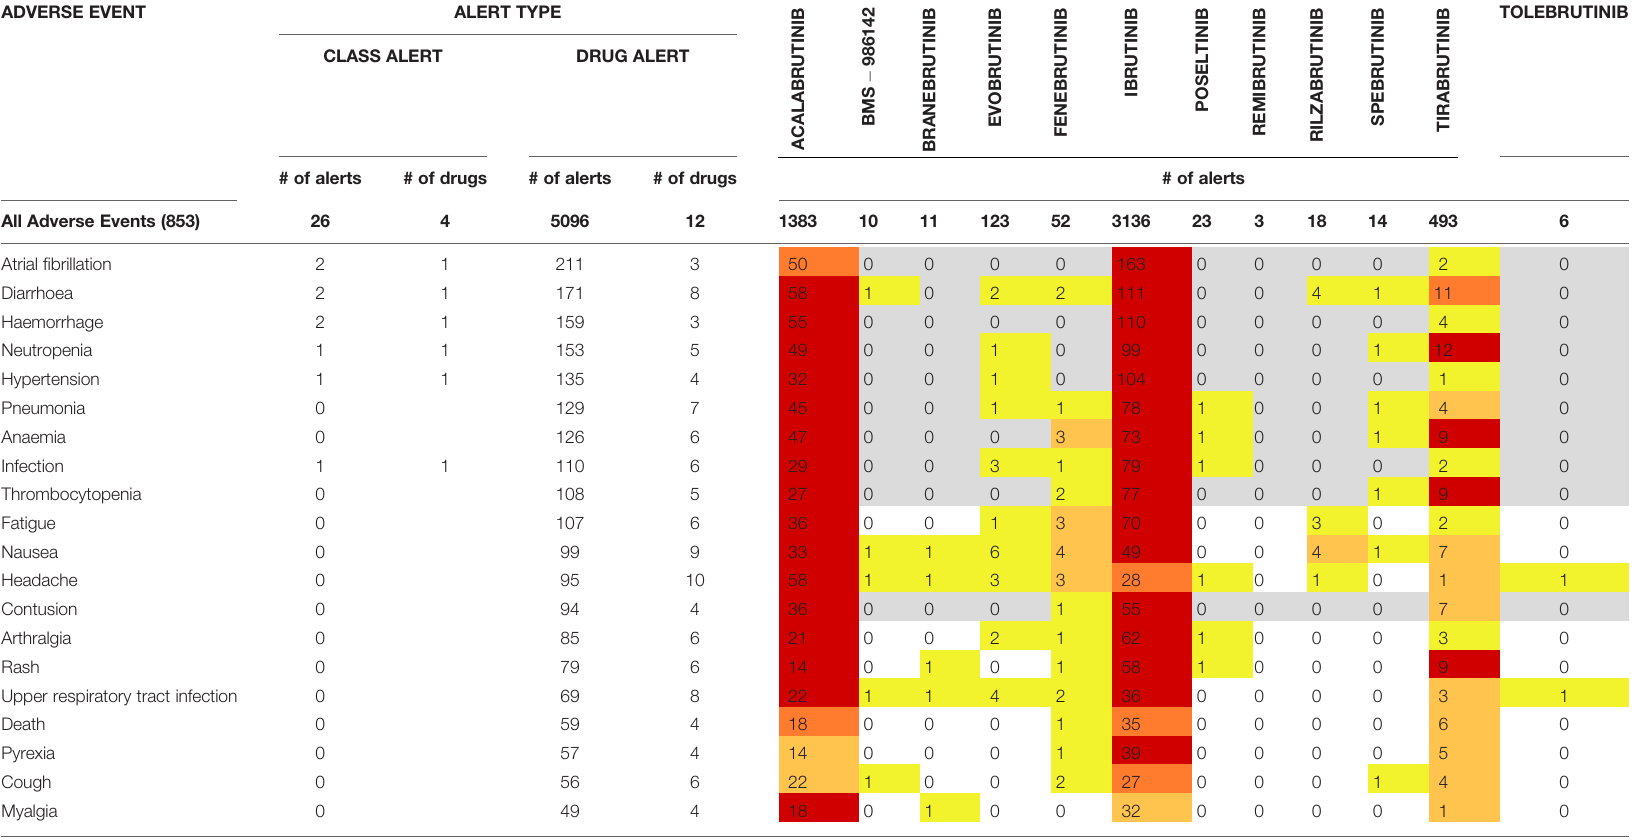
TABLE 5 | OFF-X Comparative Drug Safety Evidence showing safety fi ndings for BTK inhibitor. ADVERSE